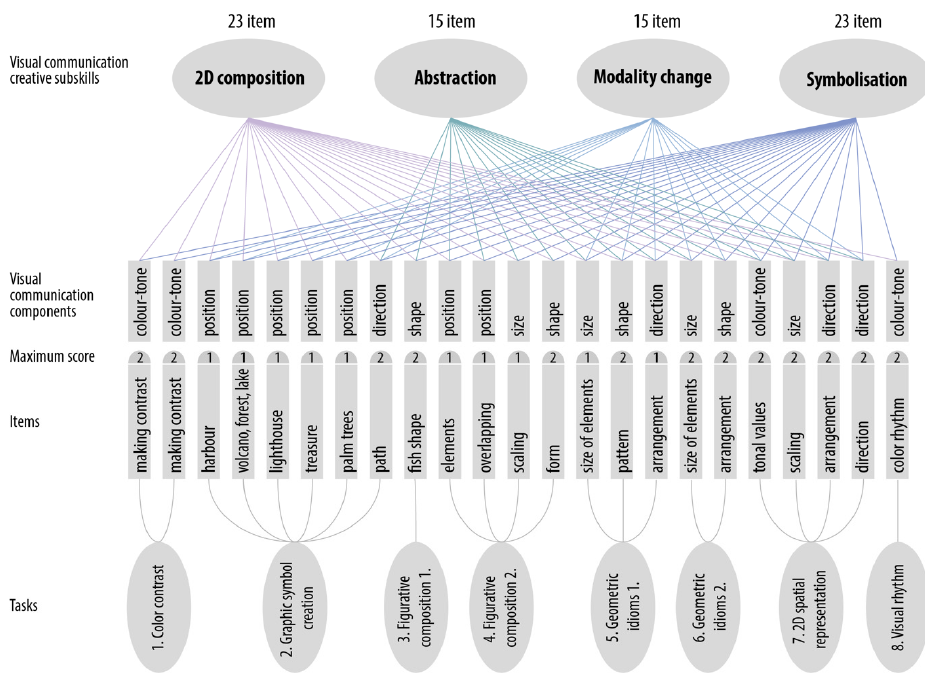
Figure 11. Digital test of visual communication: “produce” domain, Subskill structure of the tasks.